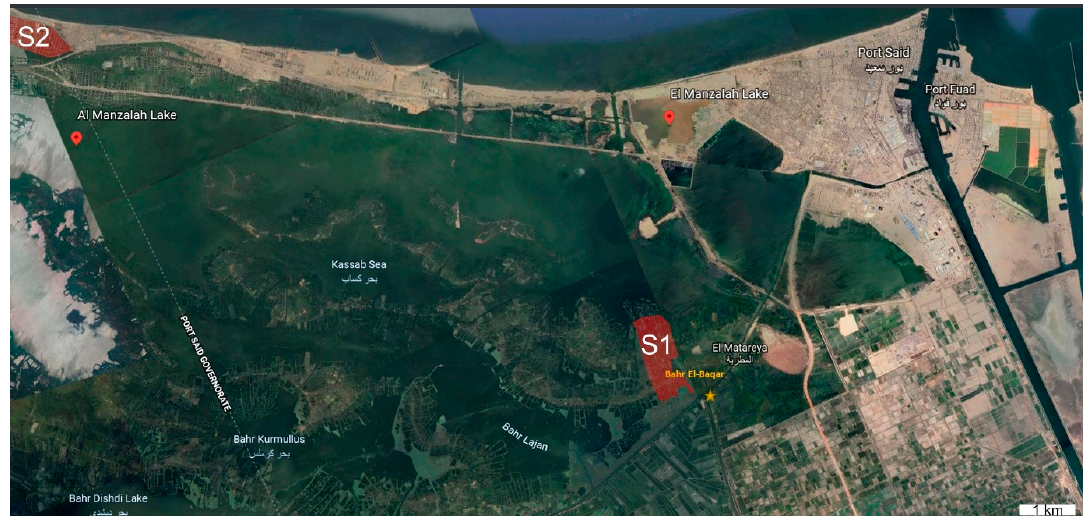
Figure 1. The study area of Manzala lagoon in the northeastern Nile delta of Egypt (Bahr El-Baqar drain, sampling sites in red marks). S1: Site 1; S2: Site